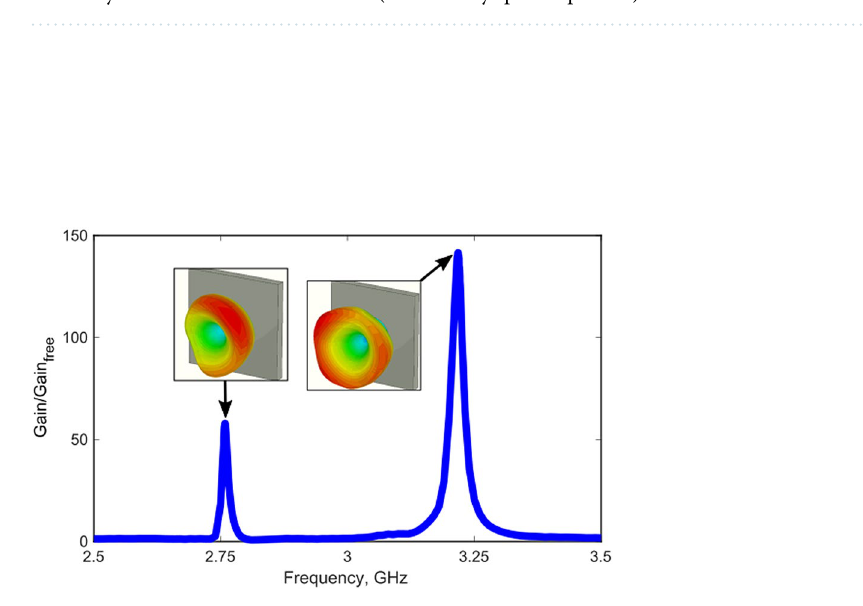
Figure 4. ( a ) Normalized magnetic field amplitude, as a function of the distance from the metamaterial surface. The excitation scheme is similar to Fig. 3a. ( b ) Power to the upper hemisphere, as a function of a dipolar emitter’s distance from the metamaterial surface (the radiating dipole is polarized perpendicular to the surface). ( c ) Total radiated power (TRP) to the upper hemisphere, when the entre scenario of Fig. 3 is considered (circular array of spheres on top of the metamaterial slab). Blue and red curves correspond to the two set of spheres, designed to provide the dual band operation. The presented values are normalized to the total radiation efficiency of the device with a flat facet (without any spheres present).